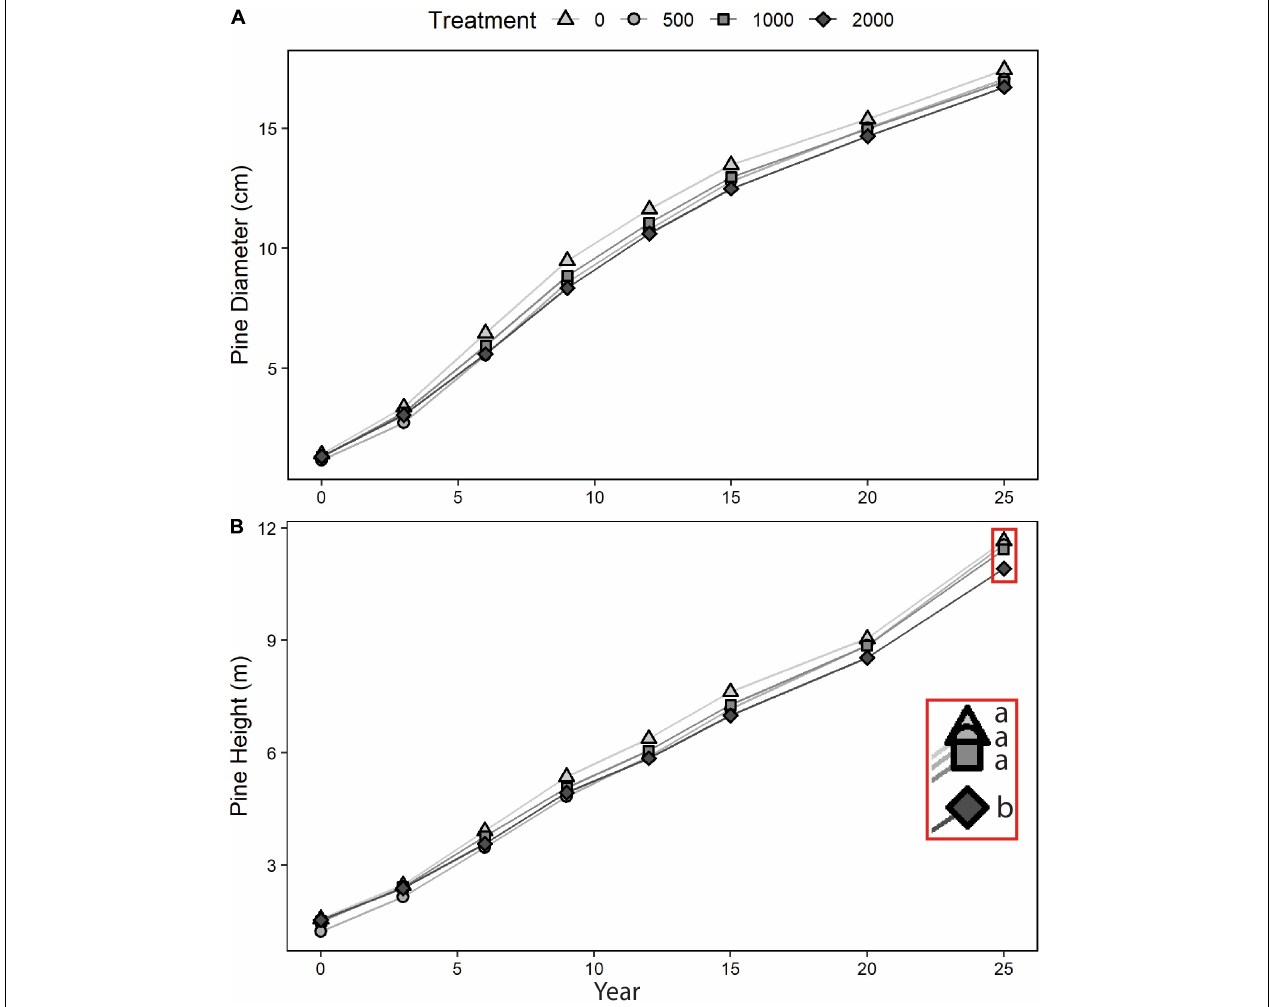
FIGURE 2 | Lodgepole pine growth, 1995–2020: (A) diameter at breast height, and (B) height (treatment means). Different letters (a, b) indicate that year 0–25 increments were significantly different ( p < 0.05) between